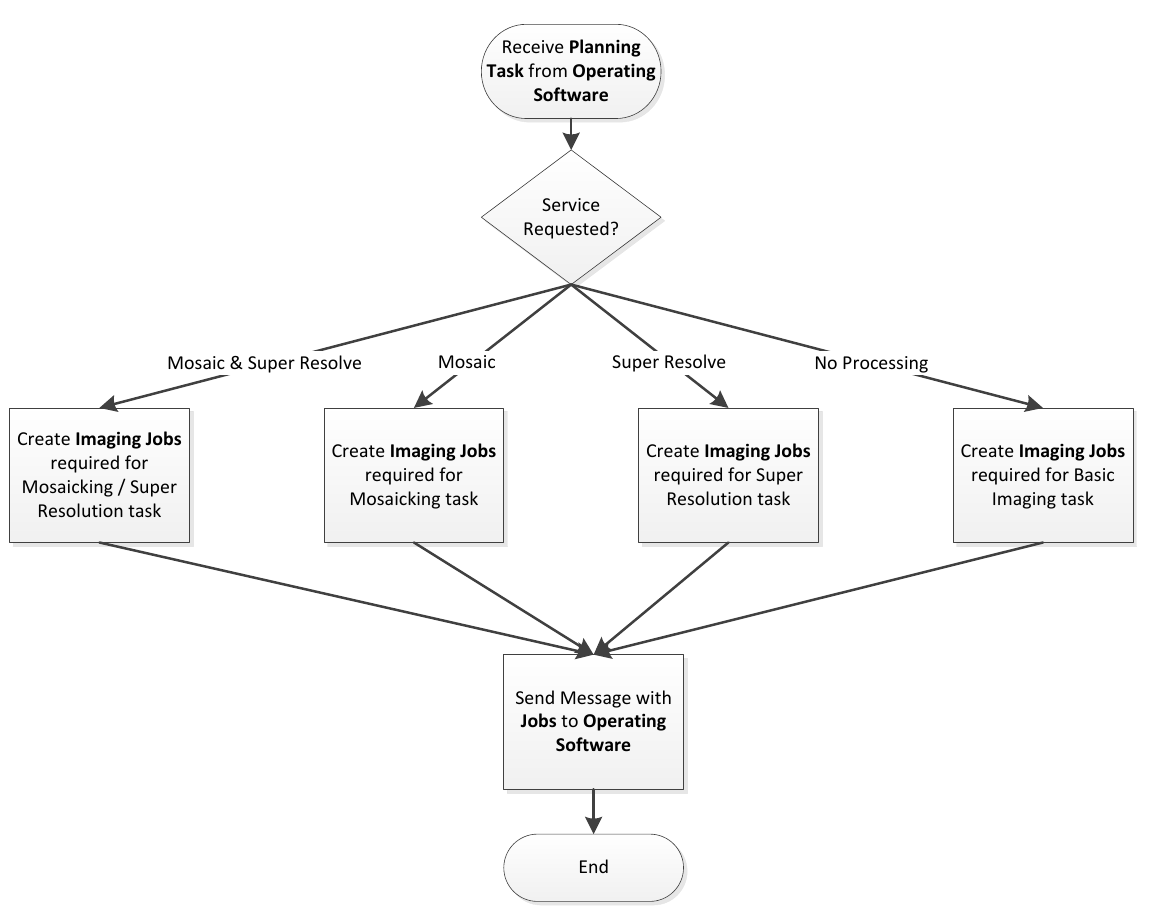
Figure 8. Payload Software Planning Task